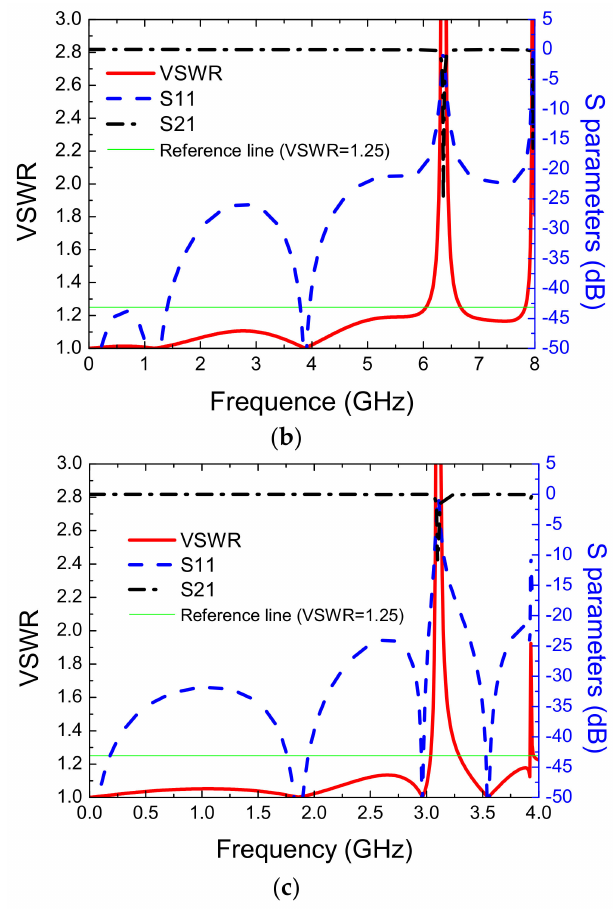
Figure 2. The simulation results of IC-Stripline cells. ( a ) Size 1; ( b ) Size 2; ( c ) Size